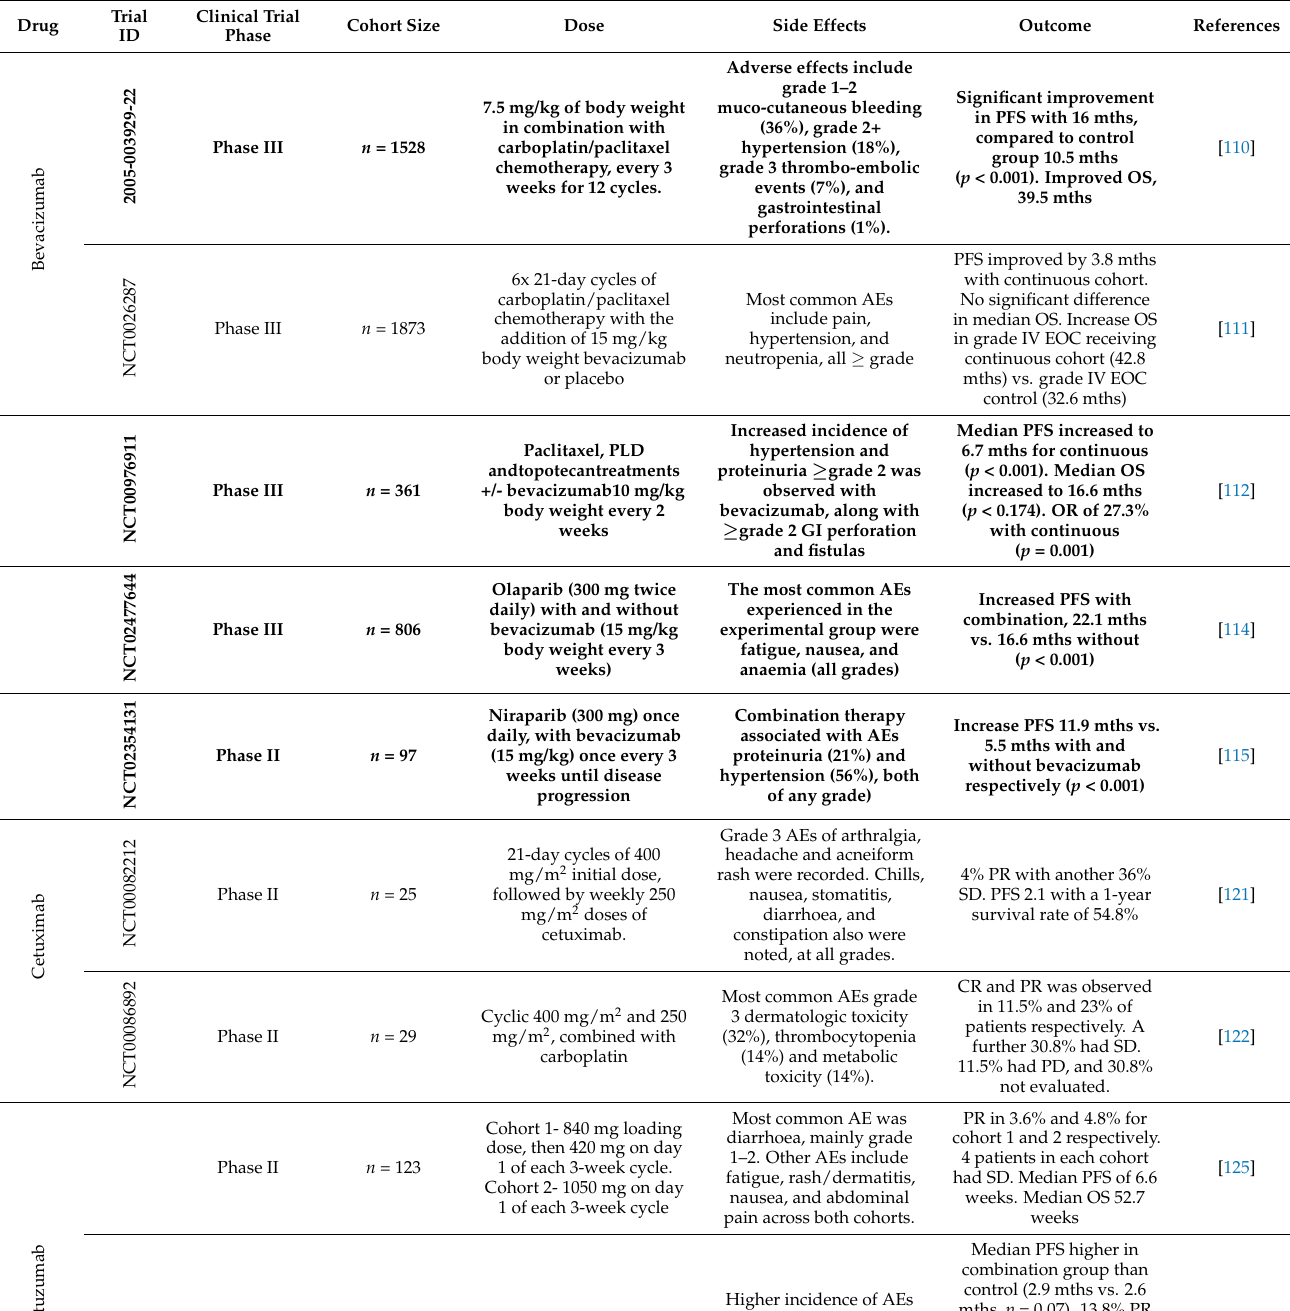
Table 2. Clinical trials involving monoclonal targeting tyrosine kinase pathways in ovarian